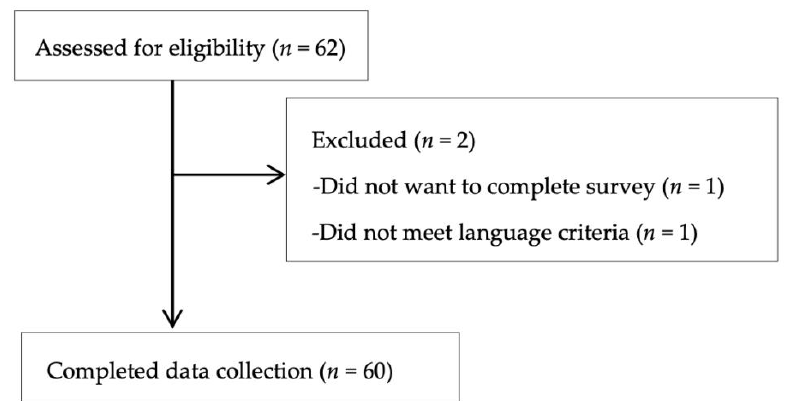
Figure 1. Flowchart of participant